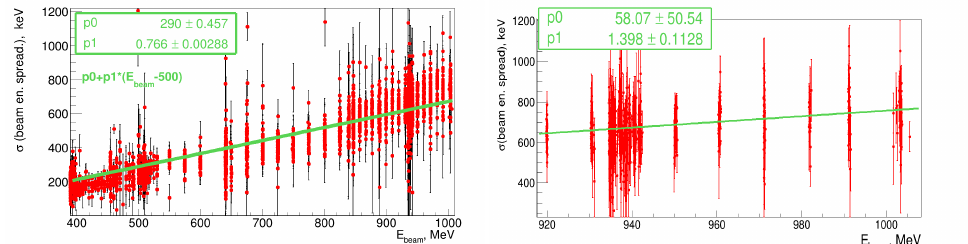
Figure 1. The measured energy spread vs beam energy for a wide energy range (left) and for the beam energies around the N ¯ N threshold. A linear fit is used for the